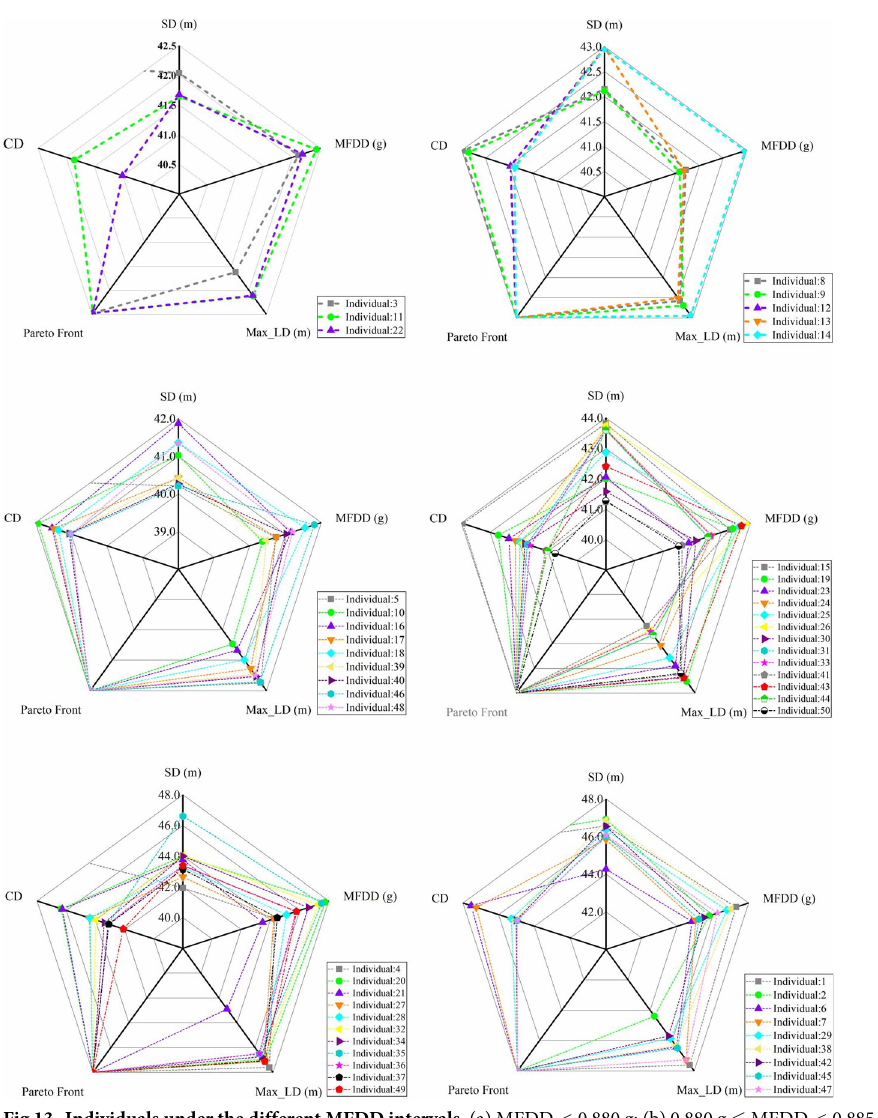
Fig 13. Individuals under the different MFDD intervals. (a) MFDD < 0.880 g; (b) 0.880 g � MFDD < 0.885 g; (c) 0.885 g � MFDD < 0.890 g; (d) 0.890 g � MFDD < 0.895 g; (e) 0.895 g � MFDD < 0.900 g; (f) MFDD � 0.900 g.